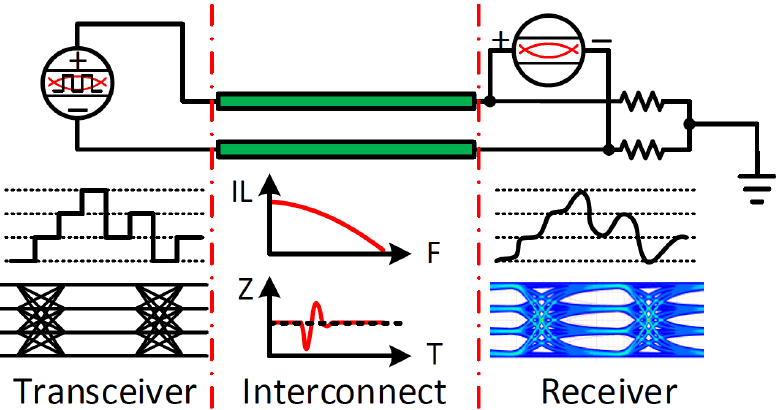
Figure 1. Off-chip interconnect in a transceiver